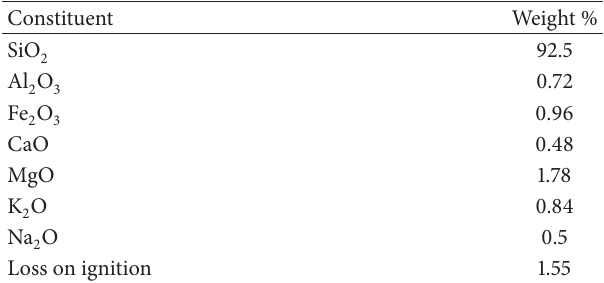
Table 4: Chemical composition of the